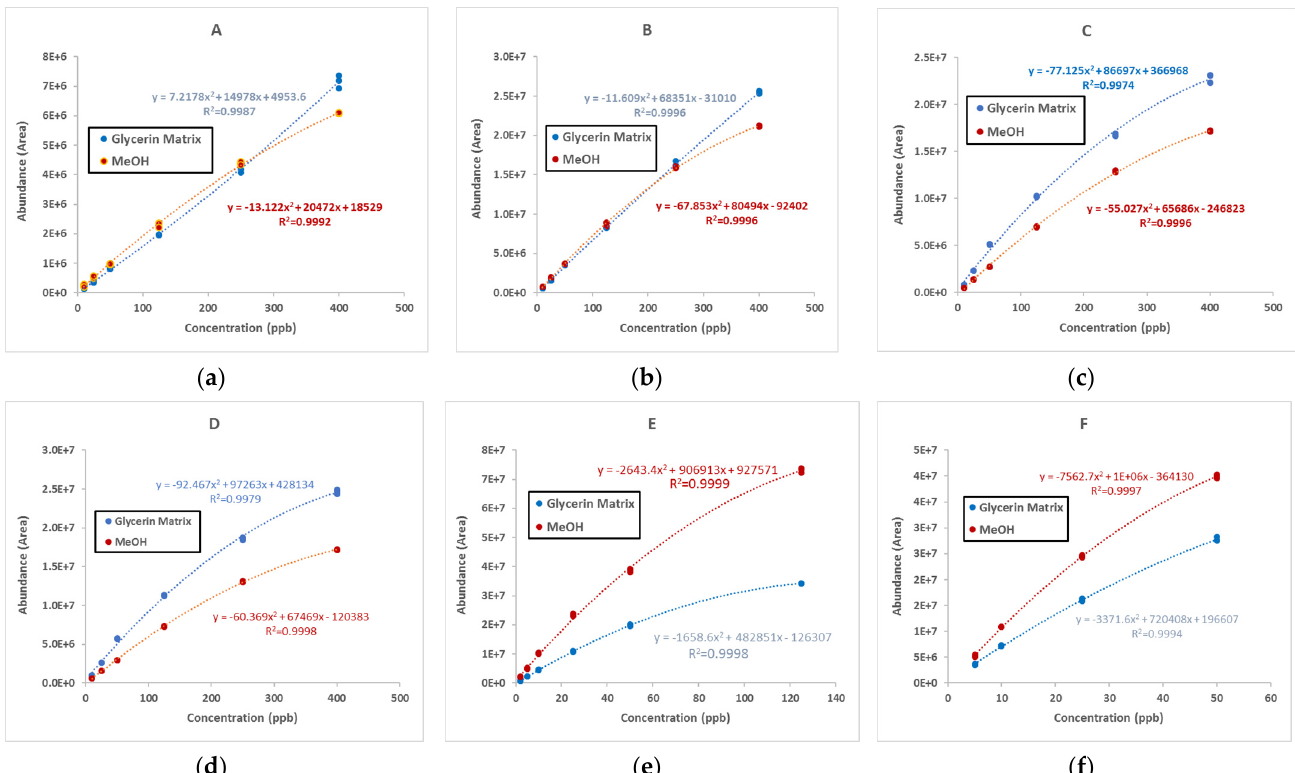
Figure 2. Calibration curves prepared in glycerin matrix and methanol for ( a ) palmitoyl-chloropropanediol, ( b ) oleyl- chloropropanediol, ( c ) 1-oleoyl-2-stearoyl-2-chloropropanediol, ( d ) 1-palmitoyl-2-stearoyl-3-chloropropanediol, ( e ) glycidyl linoleate, and ( f ) glycidyl linolenate.